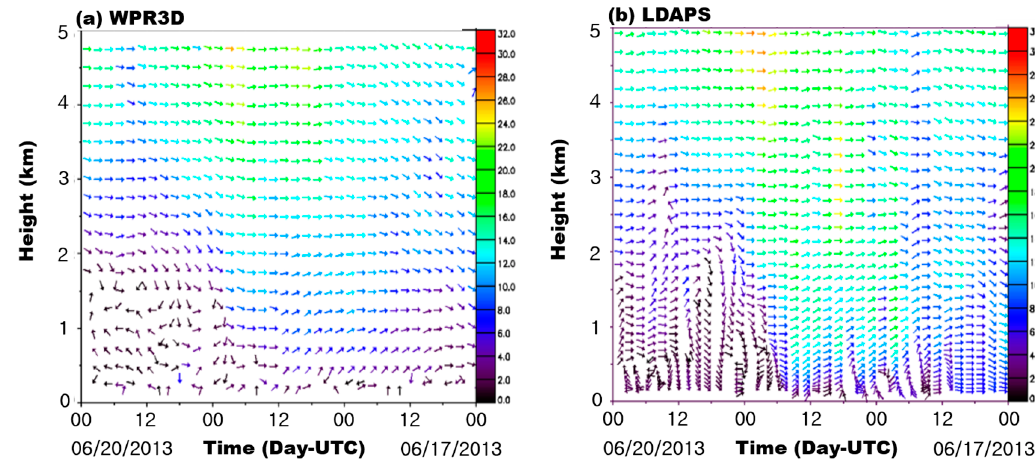
Figure 11. Wind vectors ( a ) from WPR3D and ( b ) from LDAPS at the P0 station.